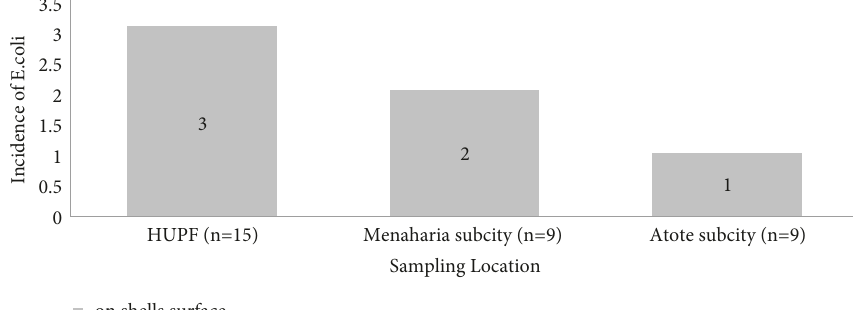
Figure 2: Incidence of E coli in shell surface rinsates of egg samples collected from different markets in Hawassa City.